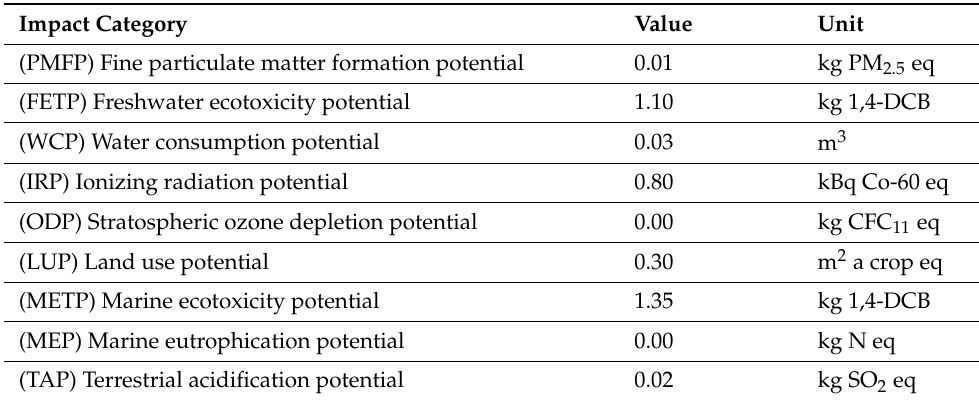
Table 3. Characterized ReCiPe Midpoint (H) impact categories for AC production from waste leaves of Quercus alba (FU: 1